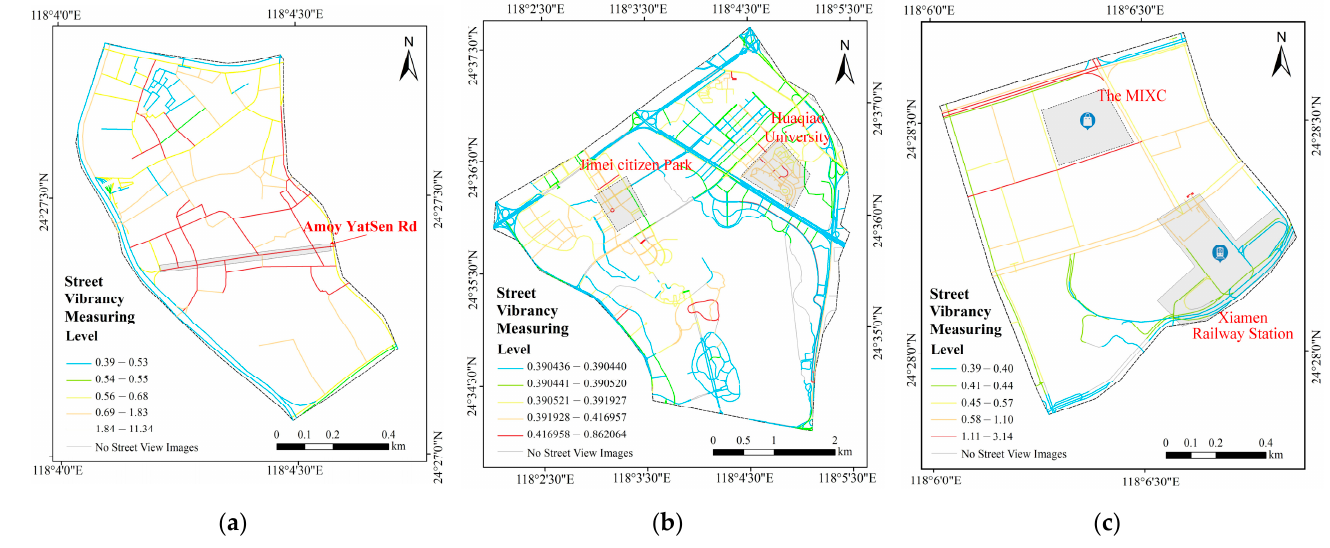
Figure 13. Visualisation results of street vitality measuring level in ( a ) Area Ⅰ , ( b ) Area Ⅱ , and ( c ) Area Ⅲ .